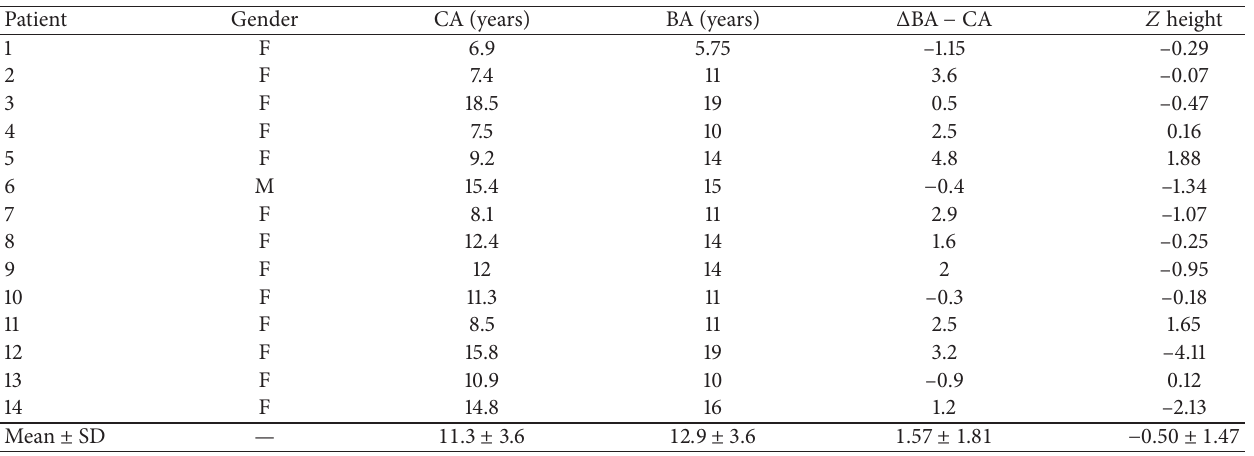
Table 1: Patient characteristics according togender, chronological age, bone age, difference between bone age and chronological age, and 𝑍 -score for height.